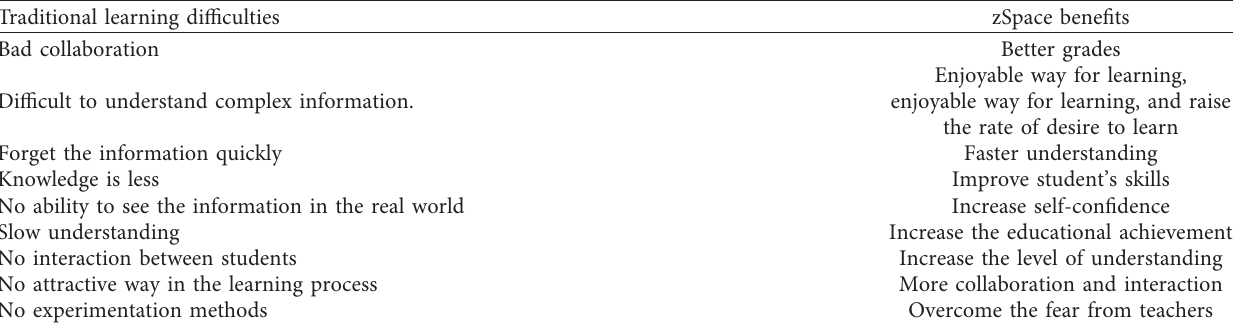
Table 10: Students’ responses after the